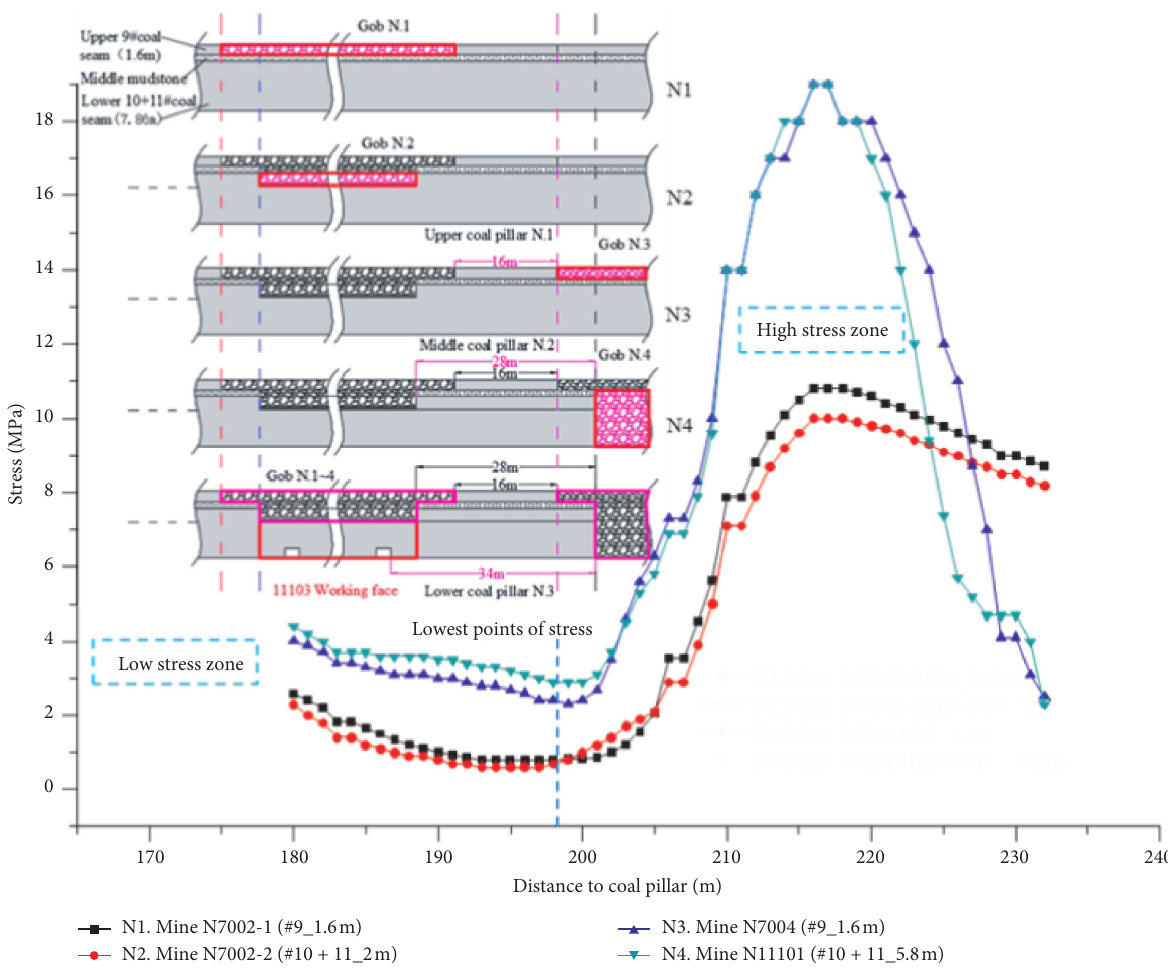
Figure 18: Mining stress change curve under double gobs in close coal